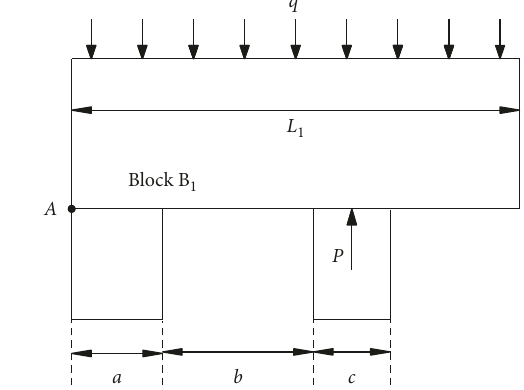
Figure 4: Mechanical model of the cantilever beam Table 1: Physical and mechanical parameters of coal and roof.